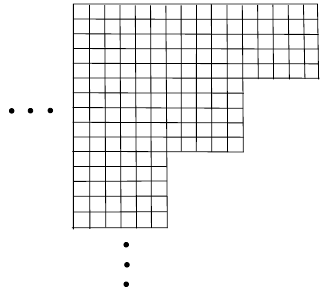
Figure 9 . The coherent states which we consider resemble the stair-case tableaus, but have the advantage that they are classical with respect to the number operator and the phase